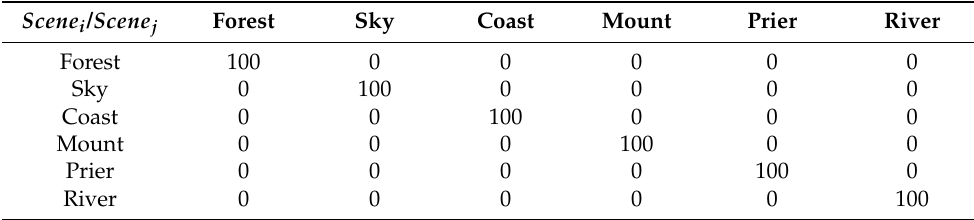
Table 2. Confusion matrix using the full image base.